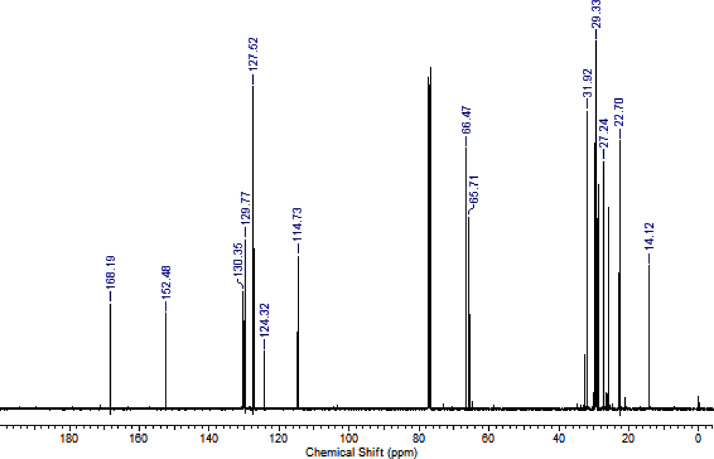
13C NMR (CDCl3, 100 MHz) spectrum of compound 6c.